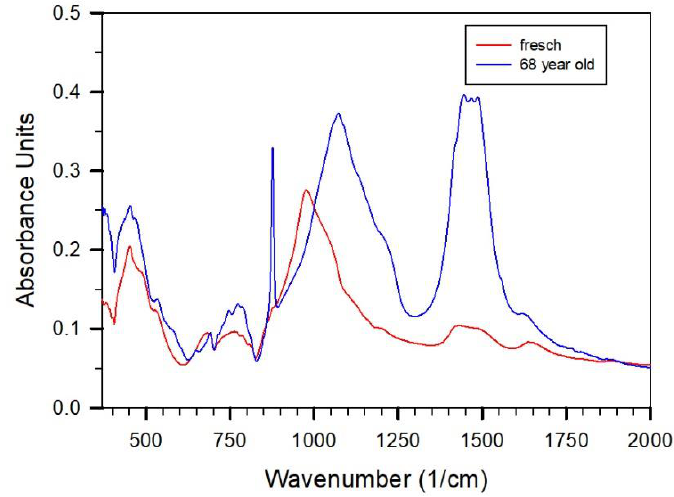
Figure 3. Absorption spectra of lime-sand brick probed from the core of a fresh brick (from Figure 2) and taken from a completely carbonated brick. In both spectra the Qz-contribution is subtracted.